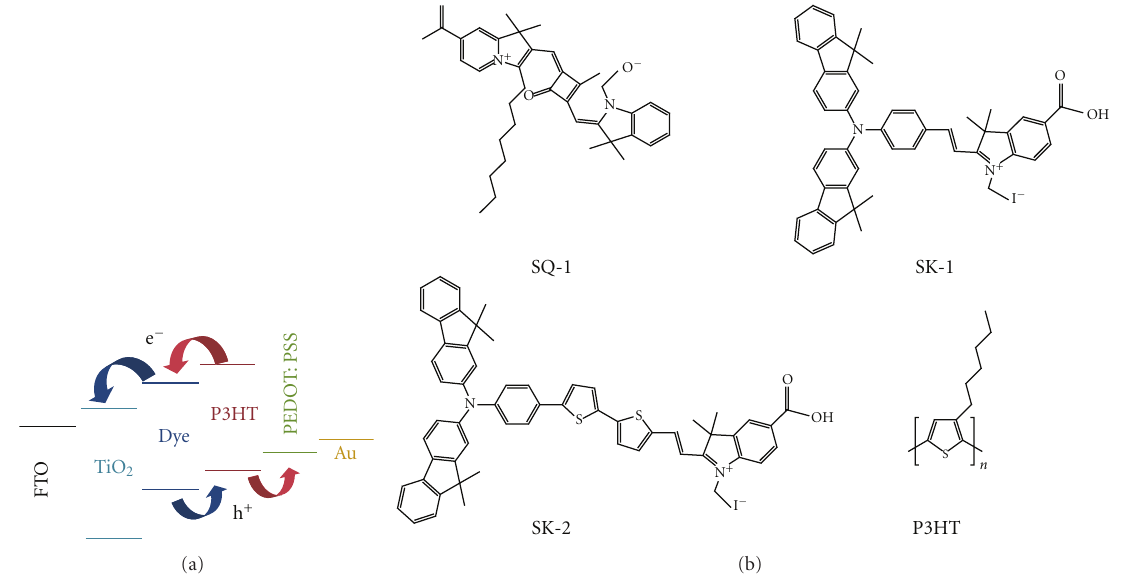
Figure 8: (a) Depiction of energy level positions and charge transfer processes of the constituent layers of the described hybrid solar cell. (b) Molecular structure of organic dyes (SK-1, SK-2, SQ-1) and P3HT polymer. Reprinted with permission from [7, 51].